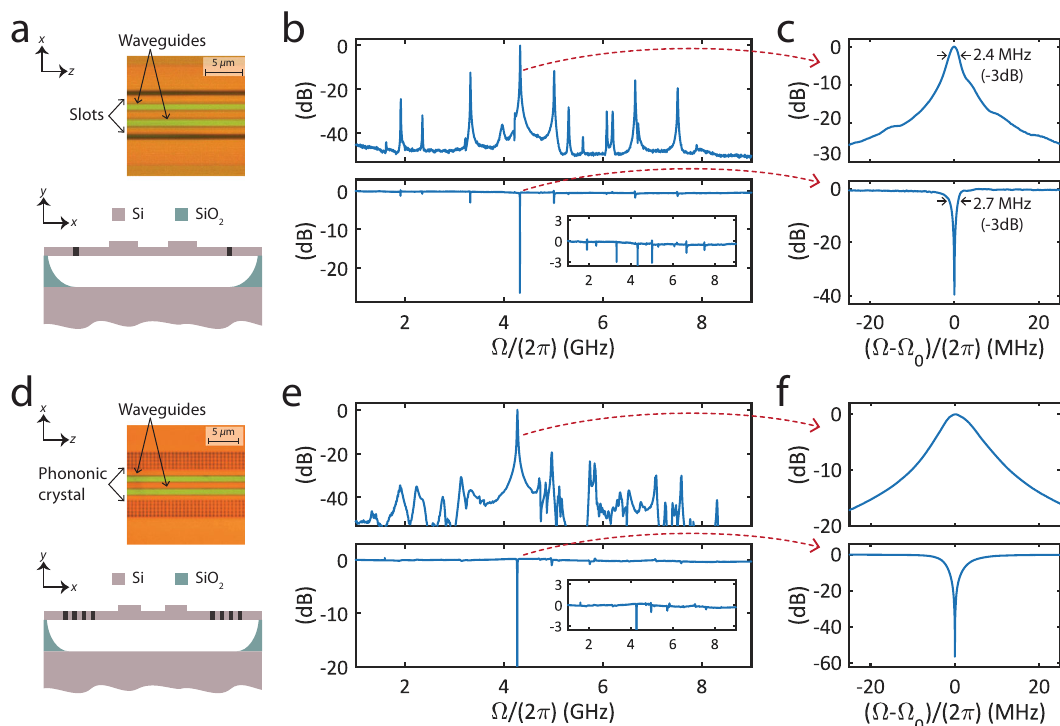
Fig. 2 Microwave-photonic frequency response. a Top: Top-down micrograph of a PPER device, showing the two ridge waveguides, and the slots used to con fi ne the acoustic mode. Bottom: Illustration of the PPER device cross-section. b Top: Measured frequency response of the PPER device, showing multiple acoustic modes. Bottom: The corresponding notch fi lter frequency response. Inset: Magni fi ed view of the pass-band ripple. c Magni fi ed view of the frequency response around Ω 0 = 4.32 GHz. Top: PPER band-pass response. Bottom: Corresponding notch fi lter response. d Top: Top-down micrograph of a PPER device utilizing a phononic crystal structure to con fi ne the acoustic mode. Bottom: Illustration of the device cross-section. e Top: Measured frequency response of the PPER device. Bottom: Corresponding notch fi lter frequency response. Inset: Magni fi ed view of the pass-band ripple. f Magni fi ed view of the frequency response around Ω 0 = 4.3